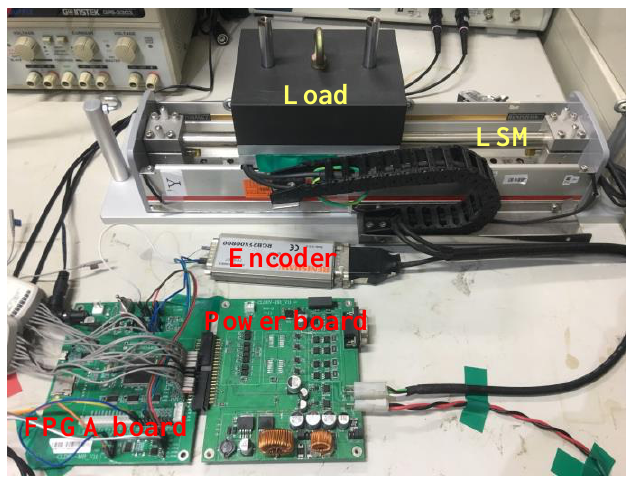
Figure 1. The experiment setup of linear shaft motor.